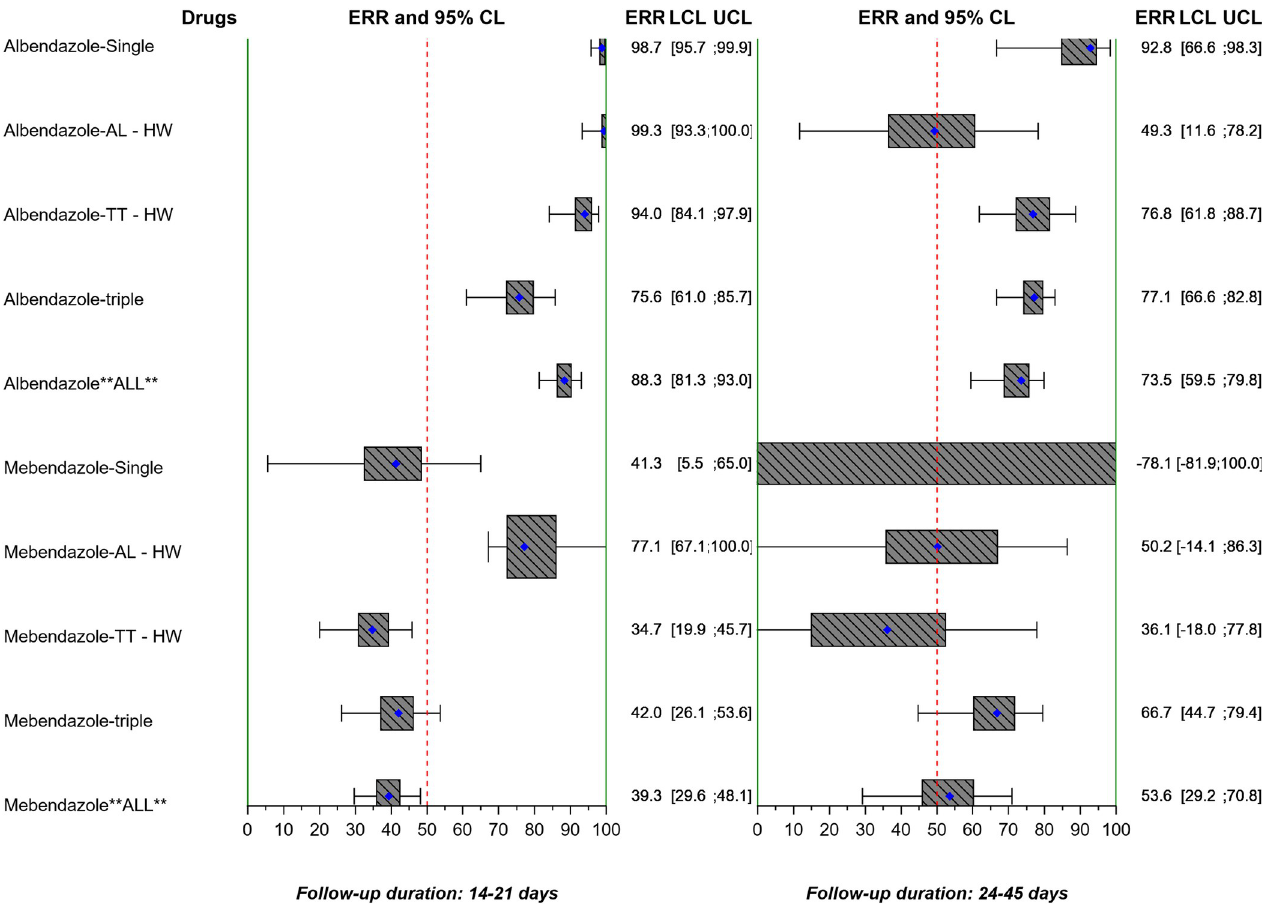
Fig 5. Forest plot of geometric mean ERR of A . lumbricoides by study. The vertical lines correspond to the WHO minimal criteria for efficacy [8] by species, as well as drug in the case of albendazole ( A . lumbricoides > 95%, T . trichiura > 50%, and hookworm > 90%), and mebendazole ( A . lumbricoides > 95%, T . trichiura > 50%, and hookworm > 70%). ERR: egg reduction rate; CL: confidence limits; LCL: lower confidence limit; UCL: upper confidence limit; AL: A . lumbricoides ; TT: T . trichiura ; HW: hookworm.